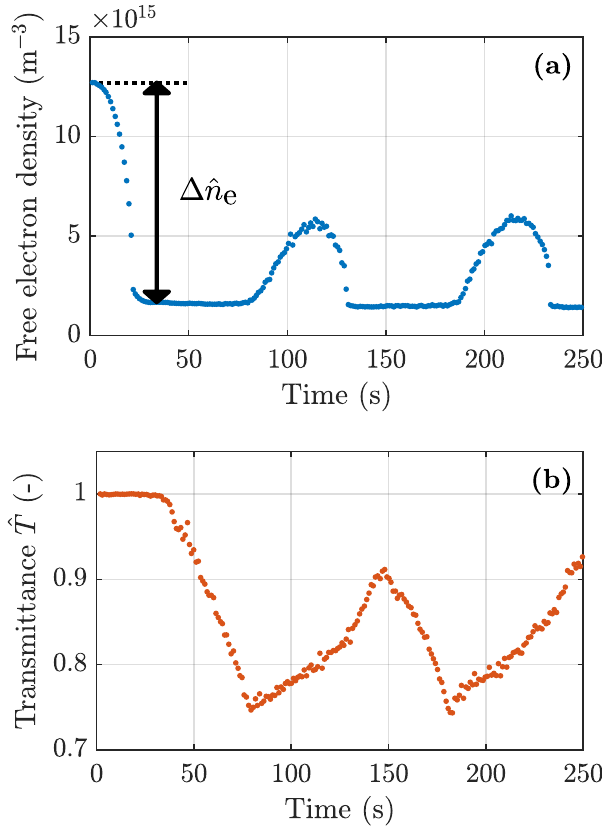
Figure 3. The free electron density ˆ n e in panel ( a ) and the transmittance ˆ T signal in panel ( b ) from the moment of plasma ignition until the end of the second growth cycle. ( a ) The free electron density has been obtained using microwave cavity resonance spectroscopy (MCRS), which clearly shows a repetitive growth pattern after the initial cycle. ( b ) The transmittance signal shows similar repetitive features, but also sharp minima and maxima that are indicative of additional growth features. The data in this Figure has been published in Tim Jacobus Maria Donders et al. [36] 2022 J. Phys. D: Appl. Phys. 55 395203 (https://doi.org/10.1088/1361-6463/ac802a) licensed under a Creative Commons Attribution (CC BY) license and used with the permission of the